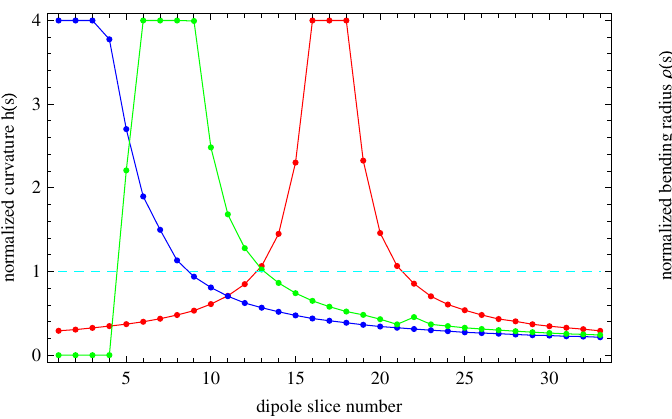
FIG. 5. Optimal bending-radius profiles corresponding to the curvature profiles in Fig. 4 for AME (blue), TME (red), and EME (green) lattices. The ramps are fairly close to linear. The glitch in the green curve is a minor imperfection in